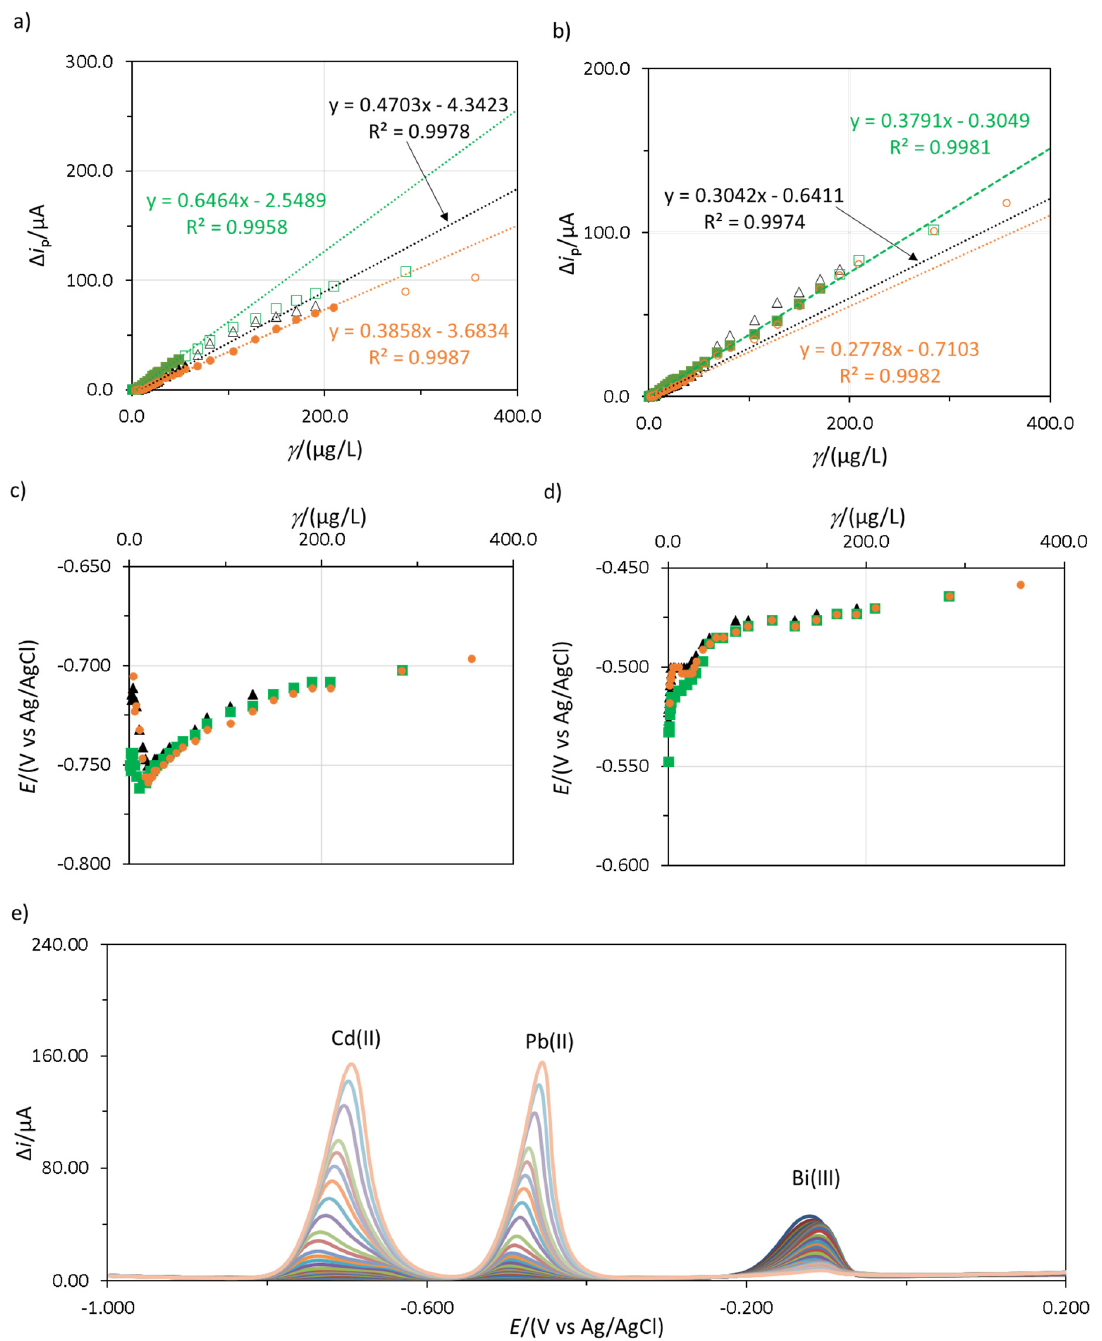
Figure 1. Three repetition measurements for determining the linear concentration ranges for ( a ) Cd(II) and ( b ) Pb(II), the stripping peak potentials vs. concentration for ( c ) Cd(II) and ( d ) Pb(II), and ( e ) the corresponding voltammogram (one out of six repetition measurements) using Electrode No. 2 tested in a fractional two-level factorial design in Table 2. The full symbols in ( a ) and ( b ) represent the calibration points within the linear concentration range, while the empty symbols represent measurements outside the linear concentration range. ∆ i p is the stripping peak